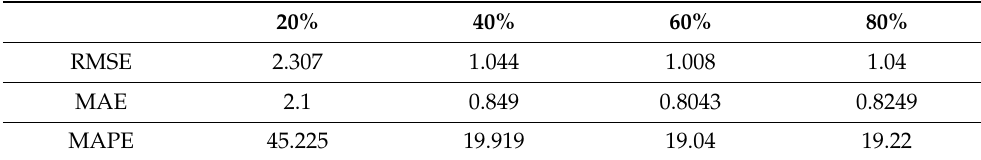
Table 11. SEResNet model weight experimental result table.